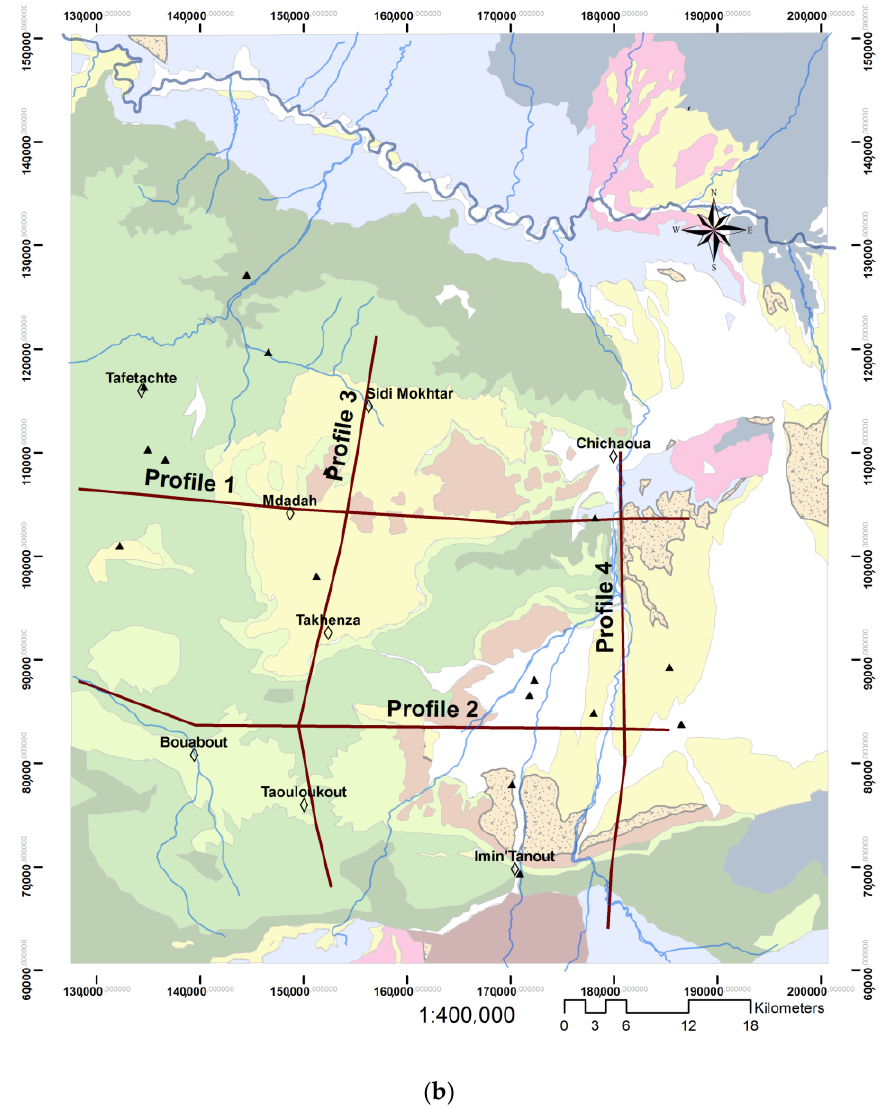
Figure 3. ( a ) Geological cross-sections; ( b ) Location of the profiles.